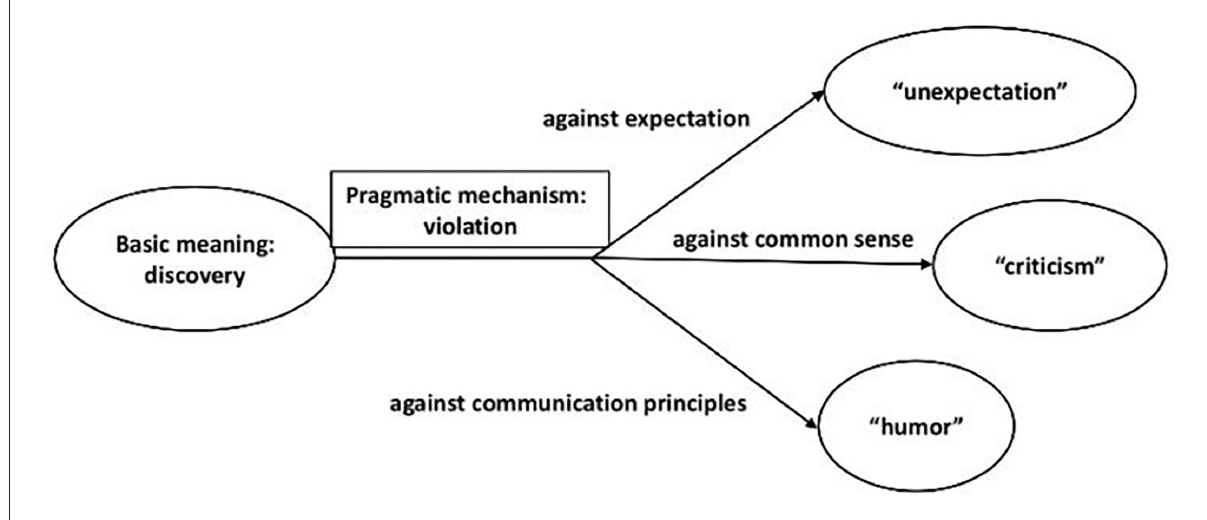
FIGURE3 The meanings and pragmatic functions of “ganqing.”